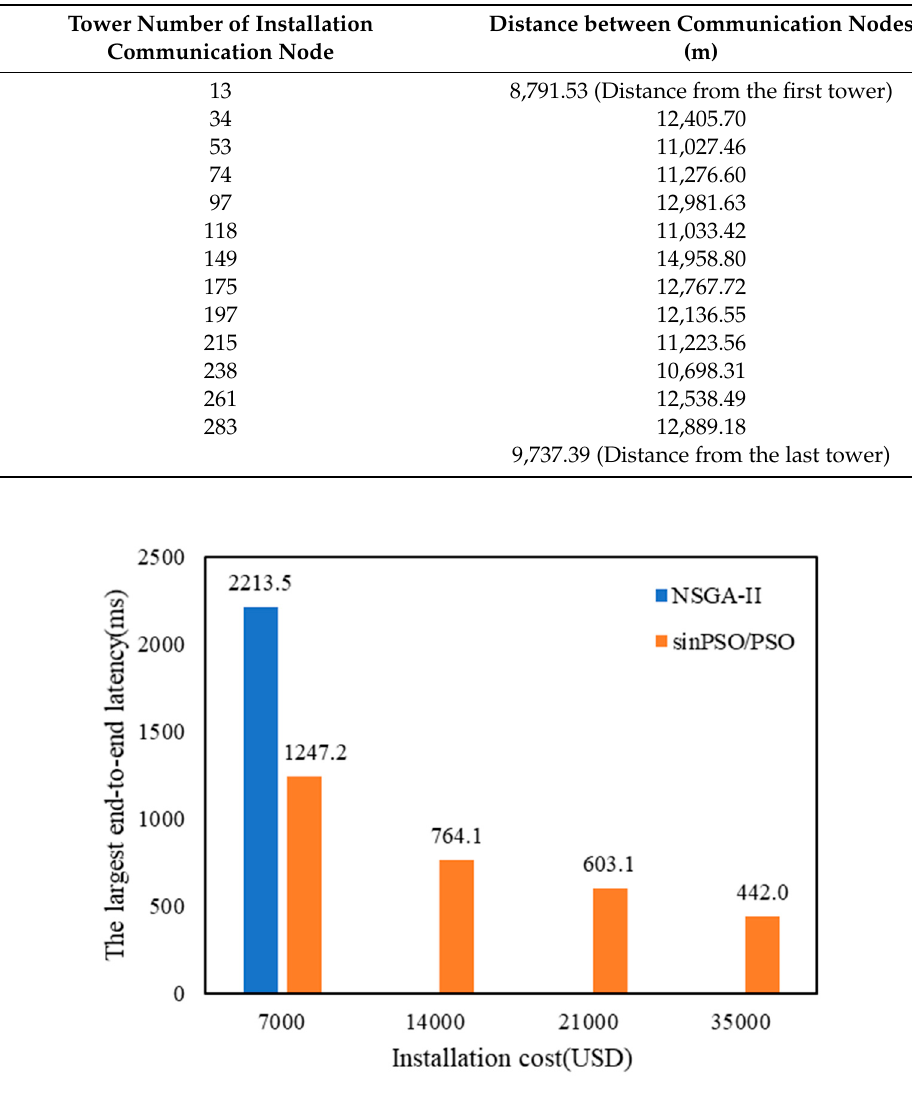
Figure 13. Comparison of deployment schemes based on maximum end-to-end delay and economic optimization. Table 7. Algorithm running time.